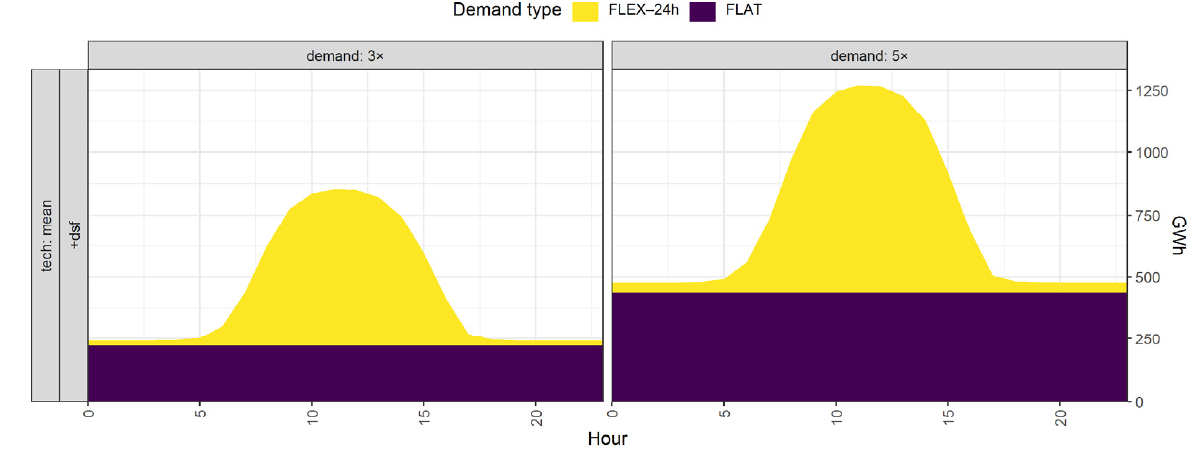
Figure 13. Final demand structure by hour, 41-year average.